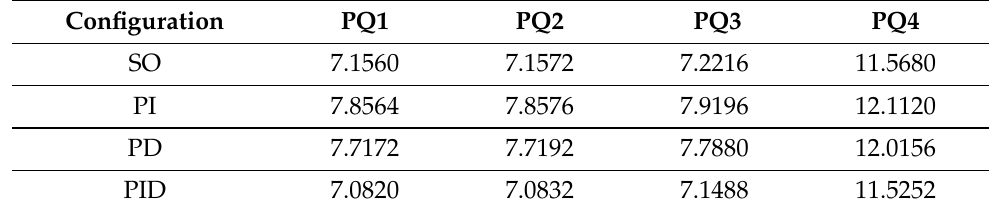
Table 2. Results of the optimization process.